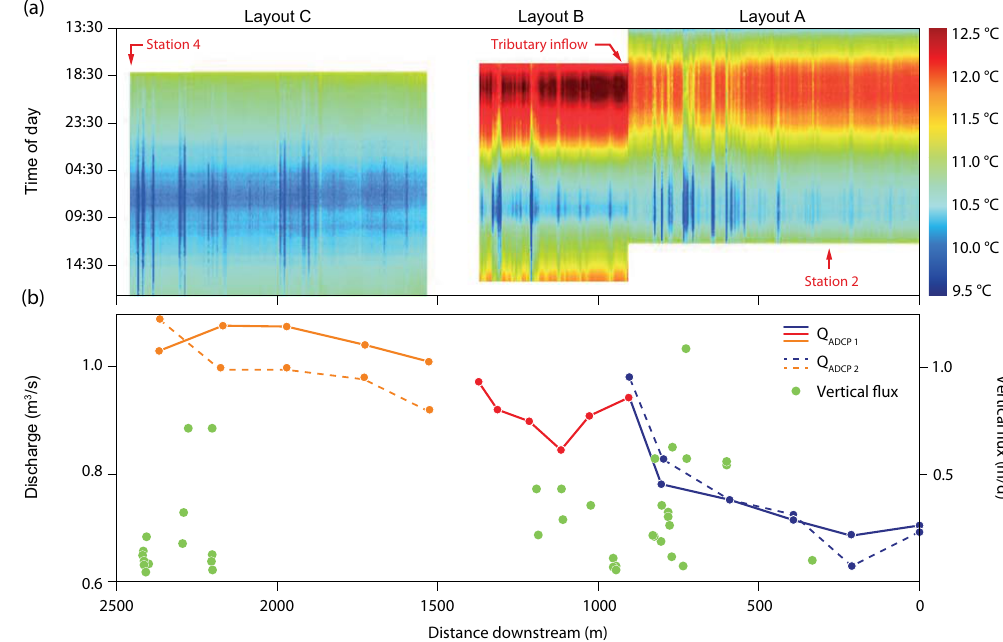
Figure 4. DTS, VTP and ADCP measurements from the campaign sampling in June 2012. (a) DTS temperatures measured in three layouts A, B and C between stations 2 and 4. (b) ADCP discharge measurements combined by trend lines. Dashed and solid trend lines represent separate measurement rounds. Uncertainties of the ADCP stream discharge measurements were all below 5% (not shown). Vertical flux points are estimated based on VTP